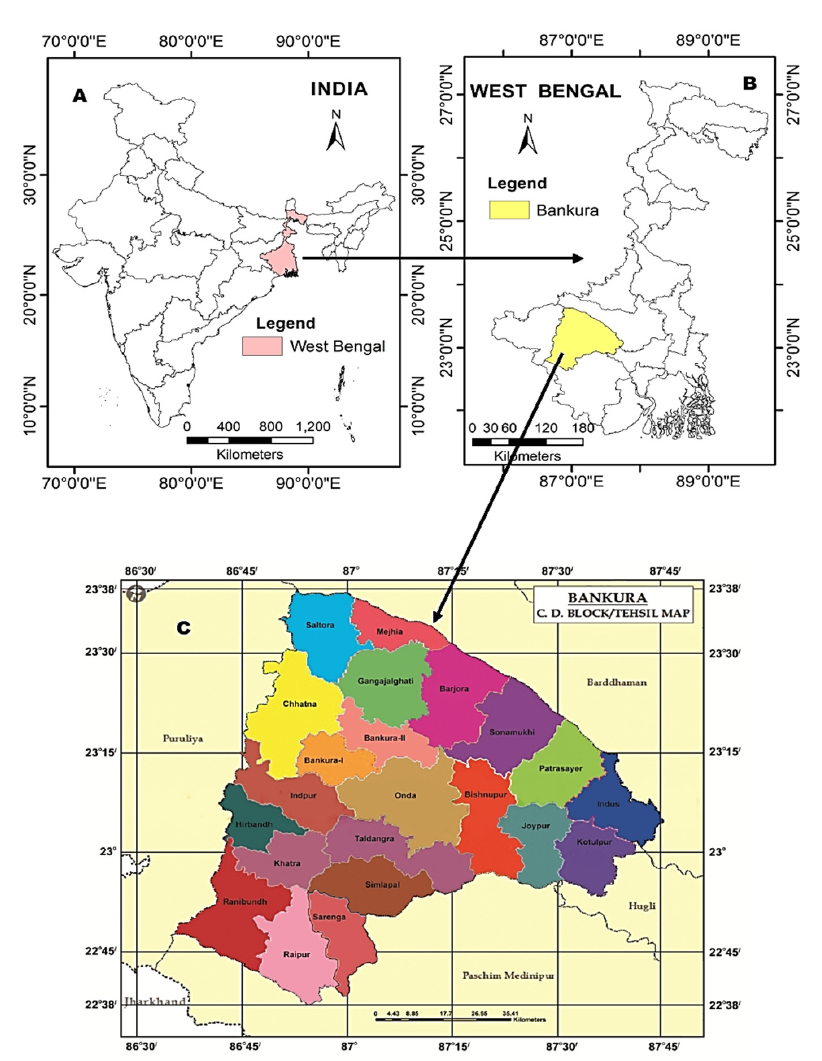
Figure 1. Geographical location of the study area: (A) Map of India; (B) Map of West Bengal; (C) Map showing the study area (Bankura district with twenty-two